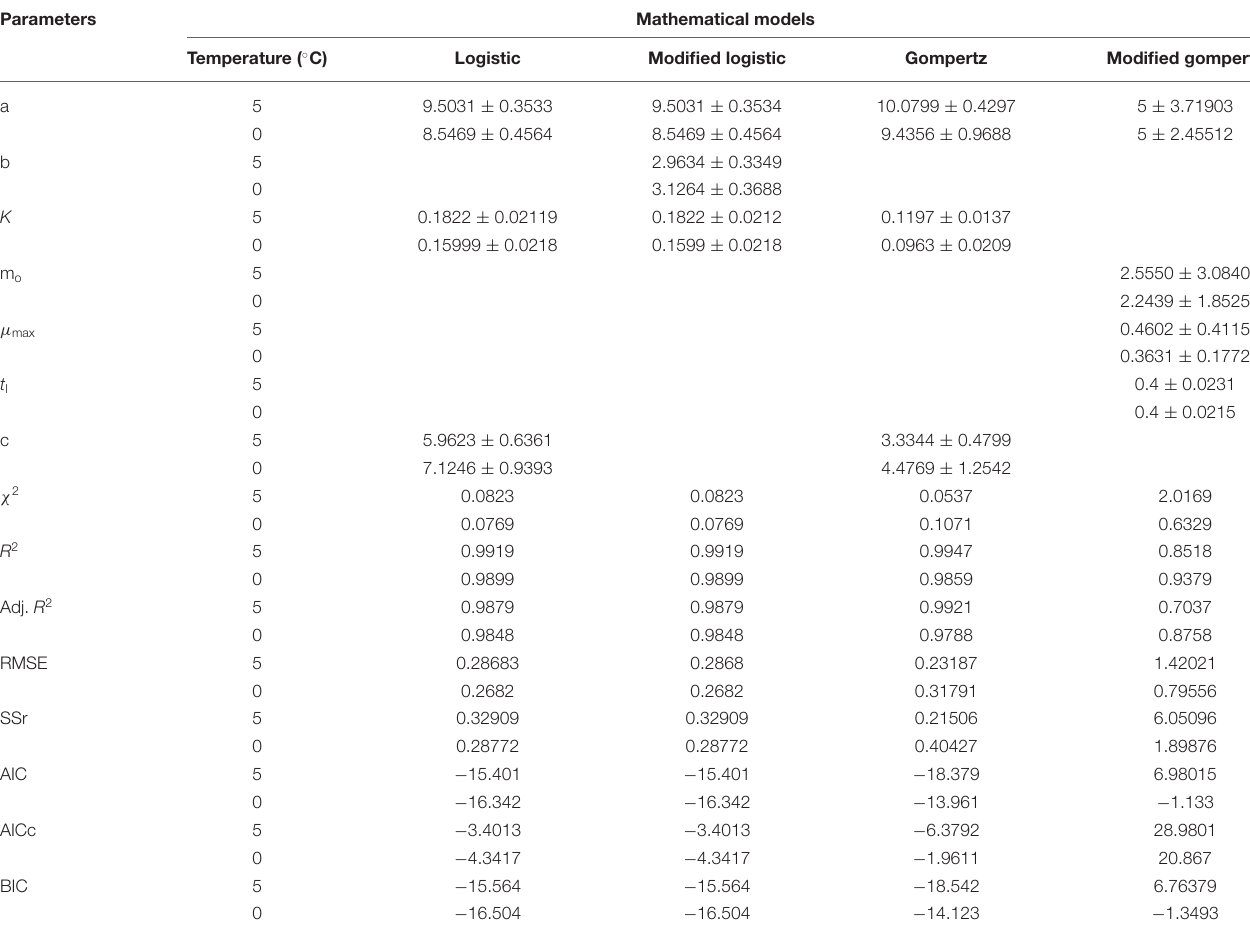
TABLE 3 | Model and statistical parameters of different empirical models for microbial growth in stored Rohu fish.